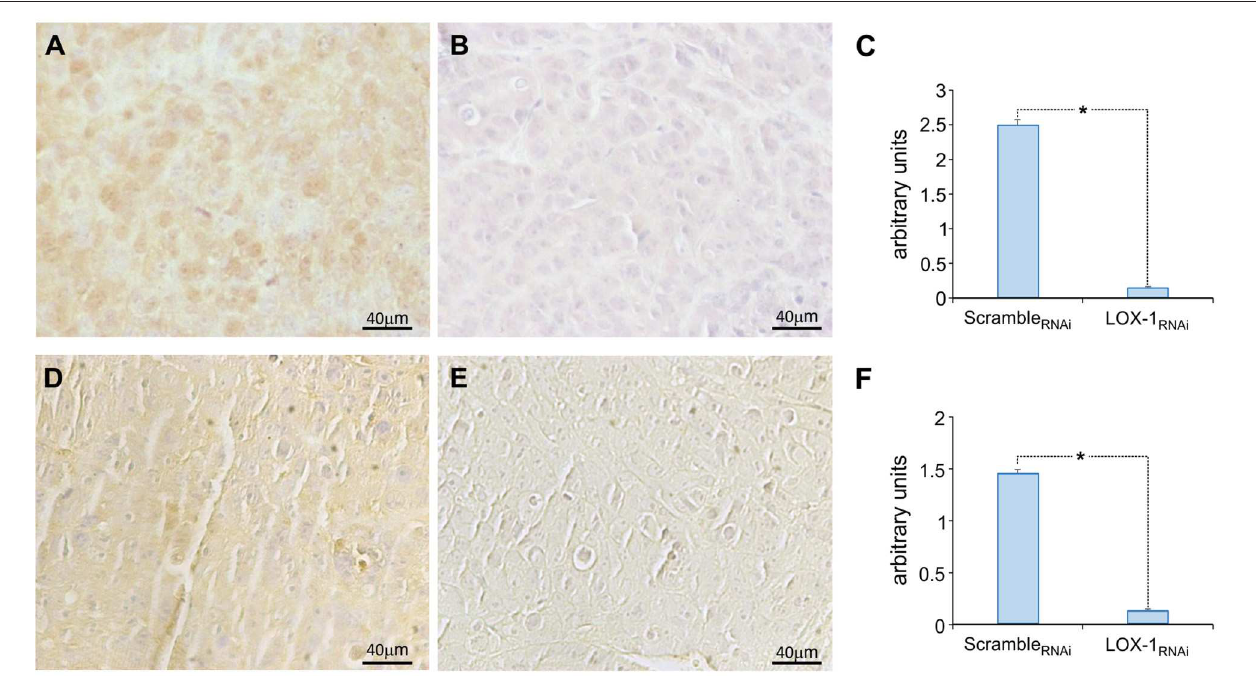
FIGURE 2 | Representative images of the immunohistochemical analysis of β -catenin and HIF-1 α expression. β -catenin expression in scramble RNAi (A) and LOX-1 RNAi (B) xenograft tumors, and HIF-1 α expression in scramble RNAi (D) and LOX-1 RNAi (E) xenograft tumors. Scale bar 40 µ m. Graphs show the significant decrease of β -catenin expression (C) and HIF-1 α expression (F) in LOX-1 RNAi respect to scramble RNAi tumors (* P <